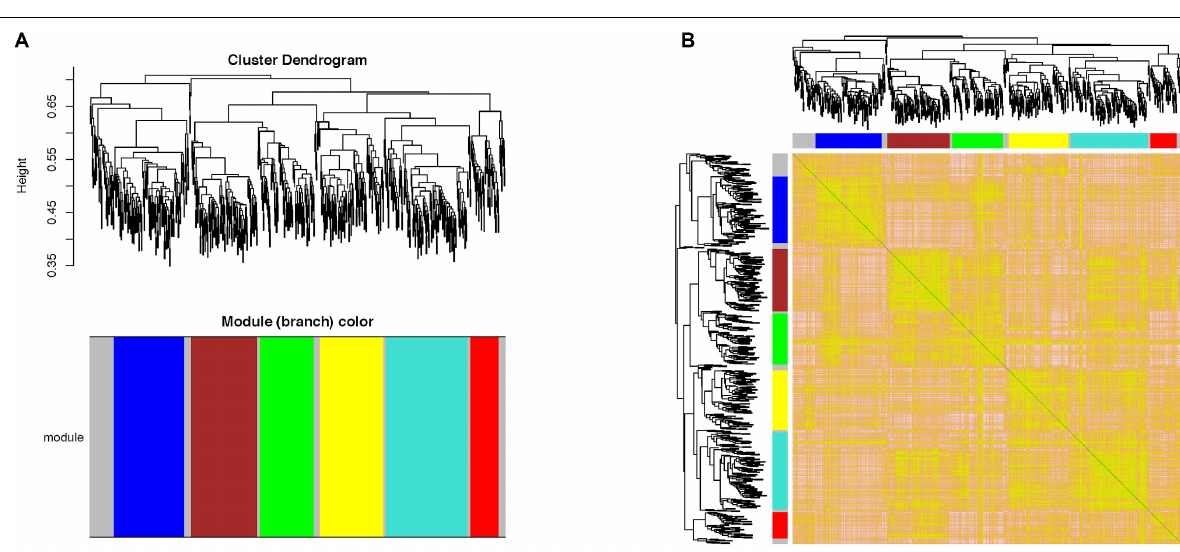
FIGURE 4 | Weighted gene co-expression network analysis of the 634 DEGs in AR. (A) Clustering dendrogram of DEGs related to AR. (B) Network heatmap plot in the co-expression modules. WGCNA, weighted gene co-expression network analysis; DEGs, differentially expressed genes; AR, allergic